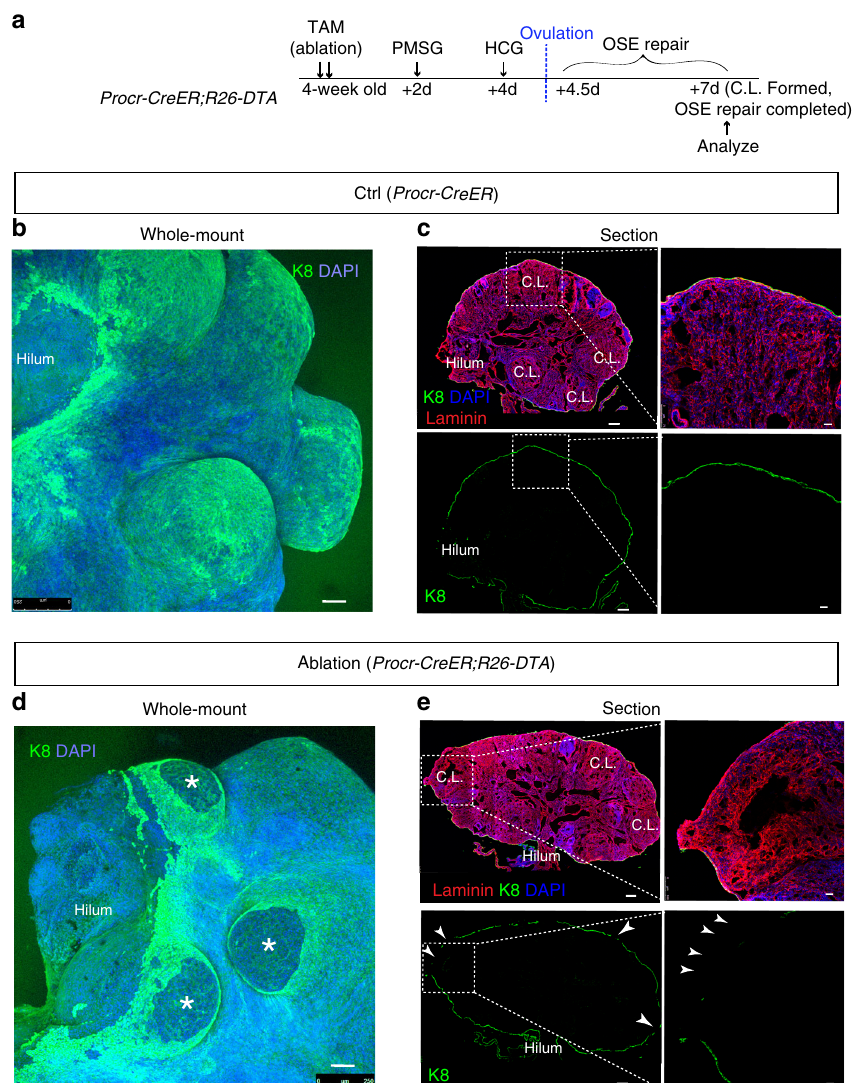
Fig. 5 Procr + cells are essential for OSE repair after ovulatory rupture. a Illustration of superovulation and the Procr + cell-targeted ablation strategy. TAM was administered to 4-week-old Procr-CreER;R26-DTA mice, following by PMSG injection at 2 days pi, and HCG injection at 4 days pi. Ovaries were analyzed at 7 days pi when the C.L formed and when OSE repair was expected to complete. b , c In the control group ( Procr-CreER ), ovary whole-mount confocal image with K8 staining indicating a complete repair at the C.L. areas, which can be distinguished by the remaining protrusions ( b ). Section image con fi rming that the OSE covering C.L. area has fully repaired with a continuous K8 + epithelial cell layer ( c ). Scale bars, 100 μ m in full ovary view and 20 μ m in zoom in view. n = 3 mice and 10 images. d , e In the ablation group ( Procr-CreER;R26-DTA ), ovary whole-mount confocal image with K8 staining showing the ruptures at the C.L. areas at 7d pi ( d ). Section image also demonstrating gaps in the OSE layer (arrow heads), esp. where C.L. areas are ( e ). Scale bars, 100 μ m in full ovary view and 20 μ m in zoom in view. n = 3 mice and 10